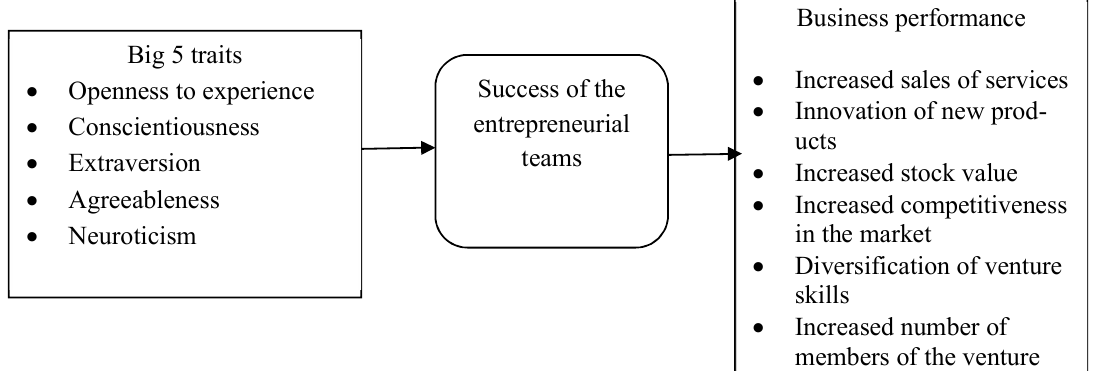
Fig. 1. The proposed